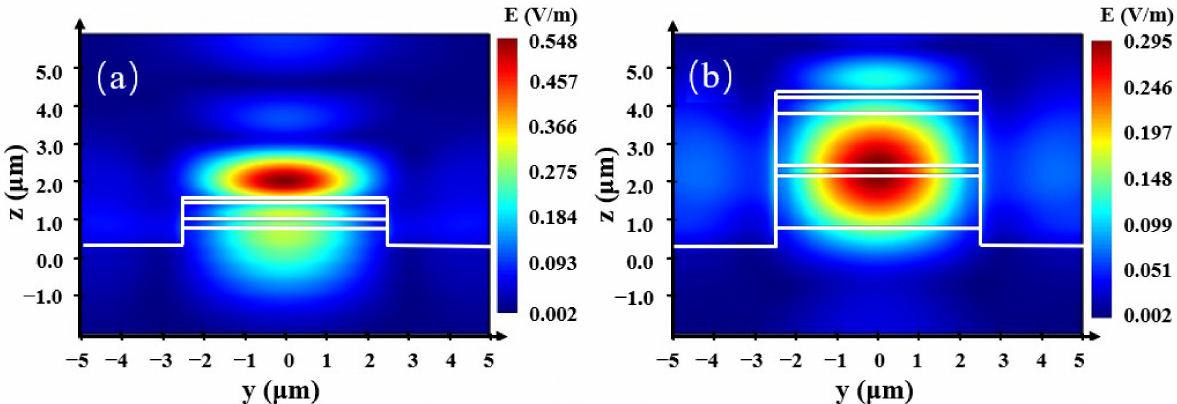
Figure 2. Cross-section of the waveguide photodetector (WGPD) with different InGa 0.24 As 0.53 P layer thicknesses: ( a ) 0 µ m thick InGa 0.24 As 0.53 P layer and 0.2 µ m thick In 0.53 Ga 0.47 As layer. ( b ) 1.4 µ m thick InGa 0.24 As 0.53 P layer and 0.2 µ m thick In 0.53 Ga 0.47 As